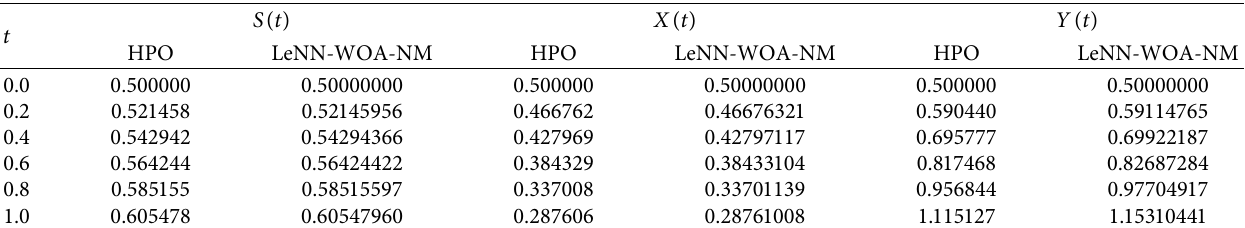
Table 2: Comparison between approximate solutions obtained by the LeNN-WOA-NM algorithm for the prey-predator system with the � 0 . homotopy perturbation method [44] for α 1